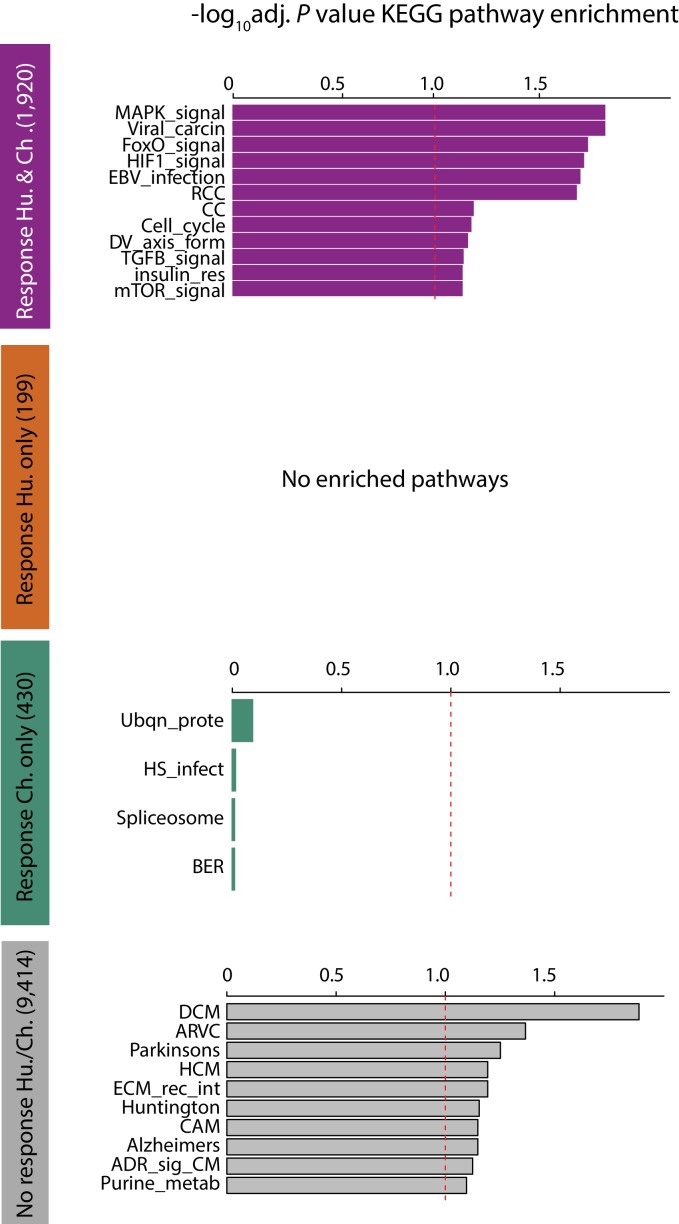
Conserved response genes are enriched in stress response pathways.KEGG pathway enrichment of genes within the four response categories. Enrichment is calculated relative to all expressed genes. Dashed red line indicates a 10% FDR threshold. Viral_carcin: viral carcinogenesis, RCC: renal cell carcinoma, CC: colorectal cancer, DV_axis_form: dorso-ventral axis formation, insulin_res: insulin resistance, Ubqn_prote: ubiquitin-mediated proteolysis, HS_infect: herpes simplex infection, BER: base excision repair, DCM: dilated cardiomyopathy, ARVC: arrhythymogenic right ventricular cardiomyopathy, HCM: hypertrophic cardiomyopathy, ECM_rec_int: ECM-receptor interaction, CAM: cell adhesion molecules, ADR_sig_CM: adrenergic signaling in cardiomyocytes, Purine_metab: purine metabolism.